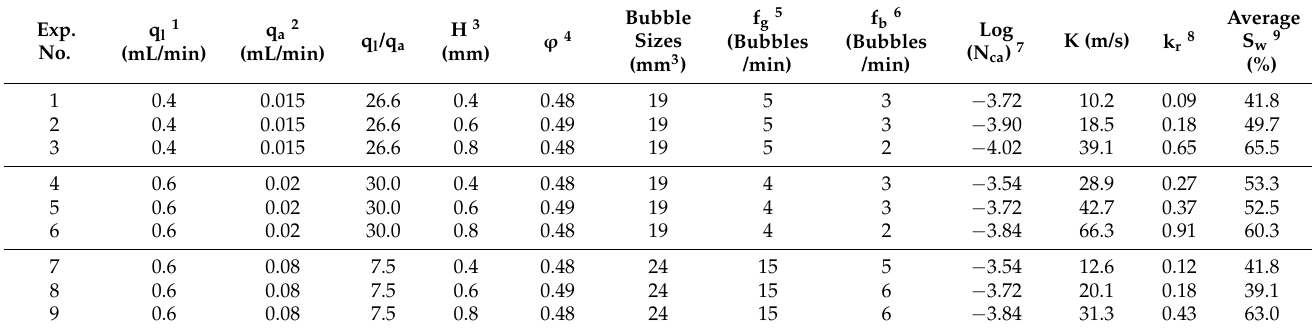
Table 1. Conditions applied during the experiments and their corresponding capillary